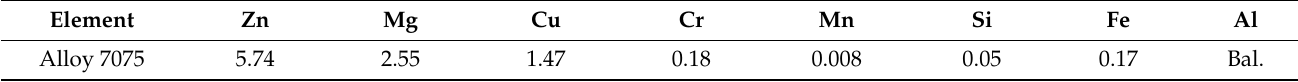
Table 1. Chemical composition of the studied Al-Zn-Mg-Cu alloys (in wt.%). Element Zn Mg Cu Cr Mn Si Fe Al Alloy 7075 5.74 2.55 1.47 0.18 0.008 0.05